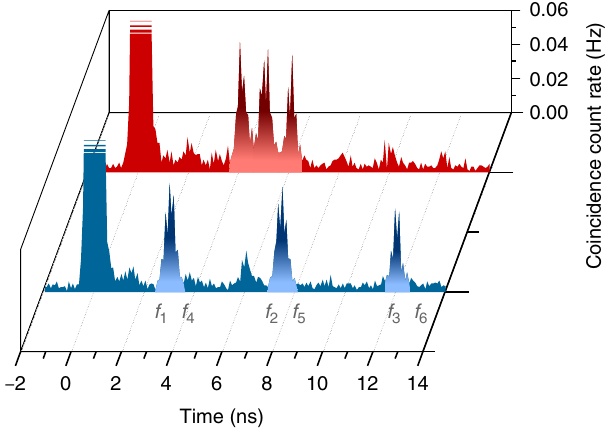
Figure 6 | Pulse manipulation. The AFC memory with total bandwidth of 2 (cid:9) 8GHz ¼ 16GHz is tailored such that simultaneously absorbed photons in six spectral modes (from f 1 to f 6 ), each of 2.65GHz bandwidth, are recalled in three temporal modes spaced either by 4.5ns (front trace), or by 1ns (back